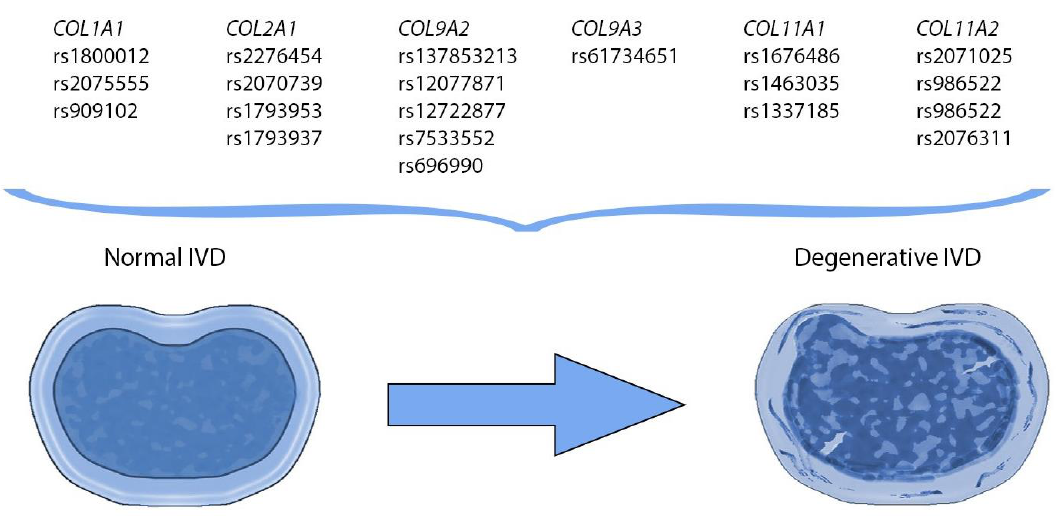
Figure 4. Candidate genes predisposing to intervertebral disc degeneration in humans.